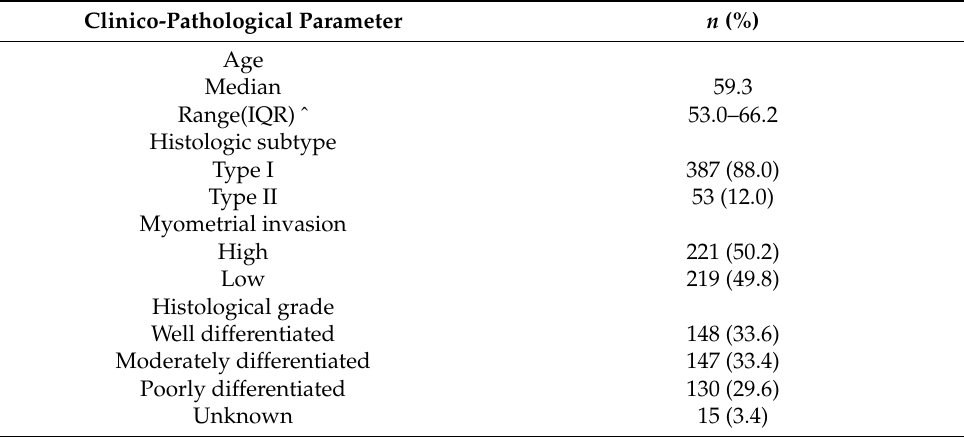
Table 1. Clinico-pathological variables for the patient cohort ( n =